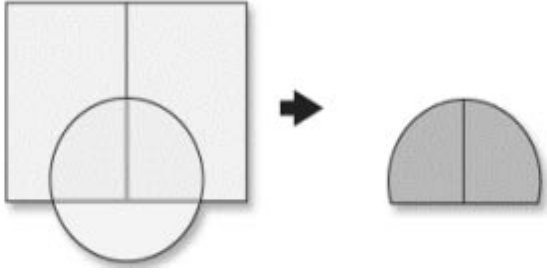
Fig 3. Example of slope aspect and value overlay